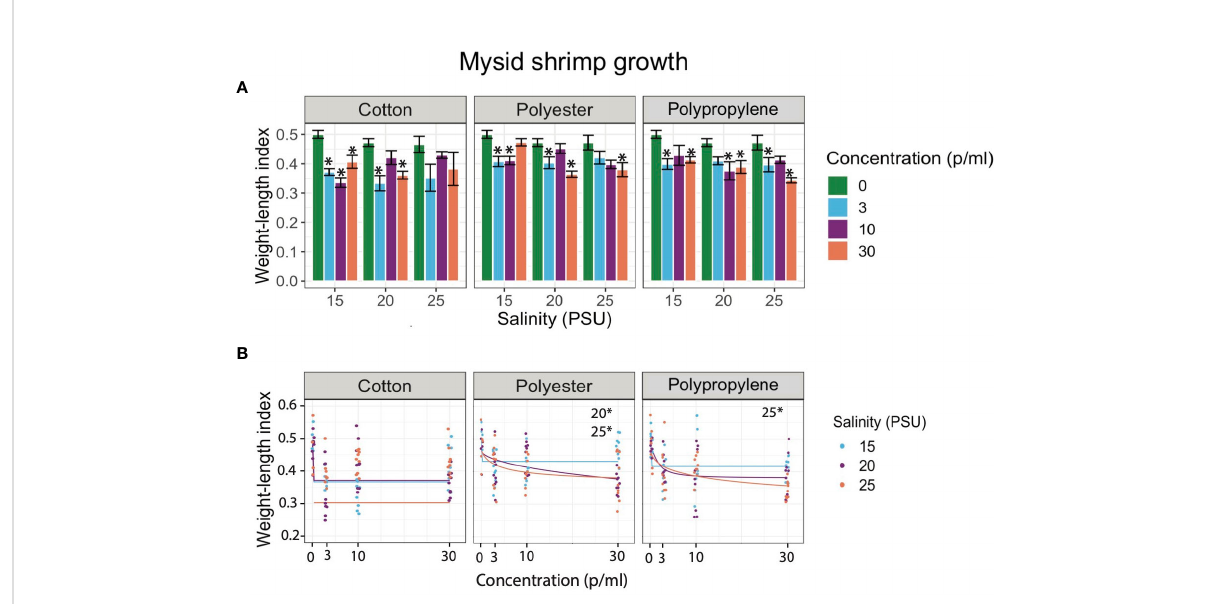
FIGURE 1 (A) Bar graphs of juvenile mysid shrimp ( A. bahia ) larvae growth exposed to cotton, polyester, and polypropylene micro fi bers across 0 - 30 p/ mL concentration and 15-25 PSU salinity gradient respectively. Asterisks represent statistically signi fi cant differences relative to the controls. Only effects relative to the control are shown ( a < 0.5; TukeyHSD). (B) Dose response curves (DRCs) of juvenile mysid shrimp ( A. bahia ) larvae growth exposed to cotton, polyester, and polypropylene micro fi bers across 0 - 30 p/mL concentration and 15-25 PSU salinity gradient respectively. Each circle in the DRCs represents the rescaled growth index mean of one larva (n=9) and regression lines are plotted from the DRC model from the R drc package. Data are presented on a log